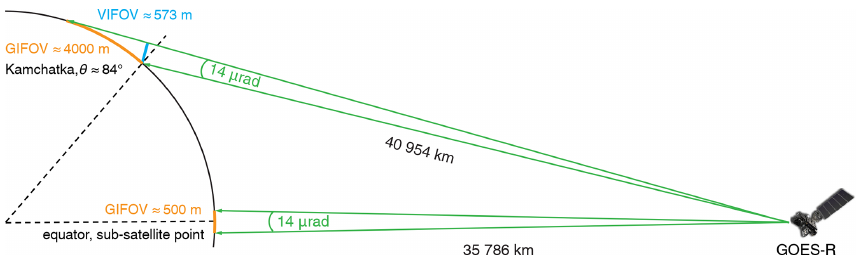
Figure 1. Horizontal (GIFOV, orange) and vertical (VIFOV, blue) spatial resolution of an ABI band 2 fixed grid pixel at the sub-satellite point and the Sheveluch volcano in Kamchatka observed at a view zenith angle of θ ≈ 84 ◦ . The fixed grid has an angular resolution of 14µrad in both the east–west and the north–south directions and is rectified to the GRS80 ellipsoid as viewed from an idealized geostationary position. Note the figure is not drawn to